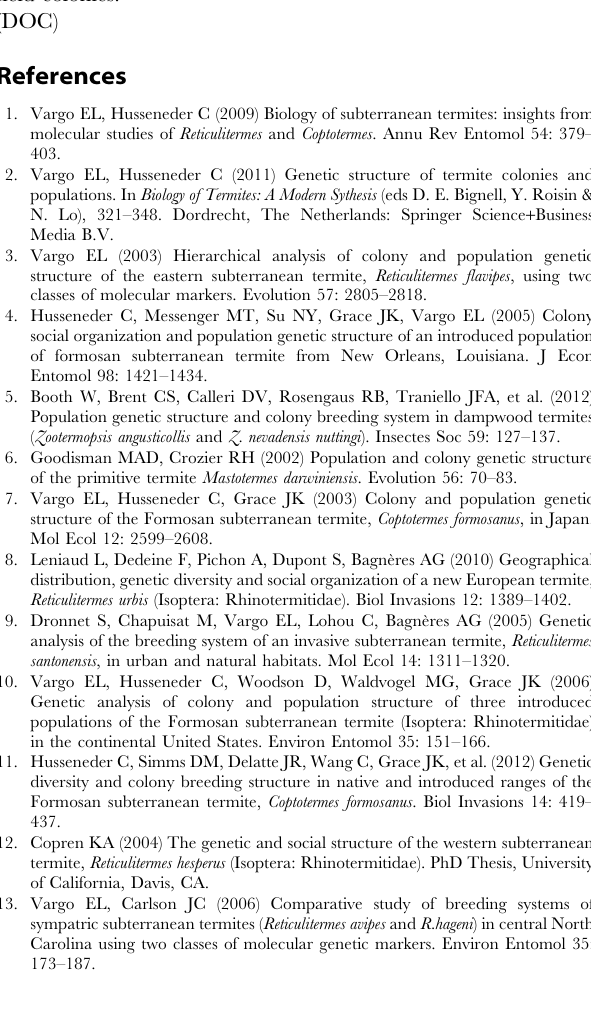
Table S3 Genotypes of secondary queens (SQ) and secondary kings (SK) from the five colonies. S: Sexually produced. Genotypes marked ‘na’ were unavailable due to failed PCR reactions. Colony numbers are the same as those in Table 3. Table S4 Latitudes and longitudes of sample sites from three geographic regions in China. Table S5 Worker genotypes at the eight microsatellite loci from Huanggang, Changsha and Chongqing Cities. Genotypes marked ‘na’ were unavailable due to failed PCR